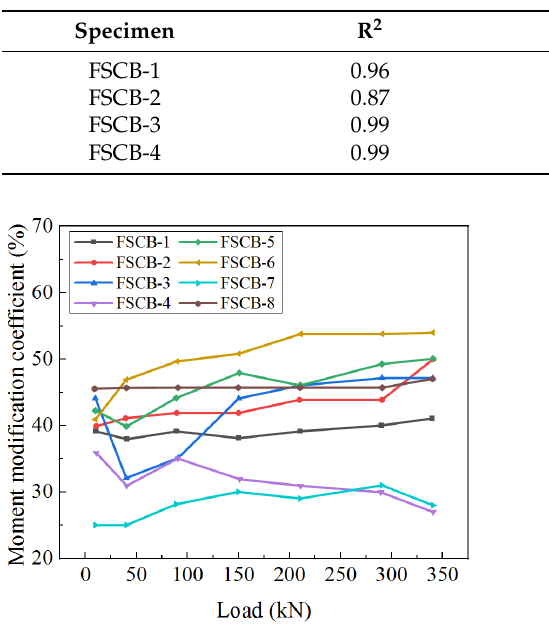
Figure 15. Relation of moment modi fi cation coe ffi cient vs. load curves.